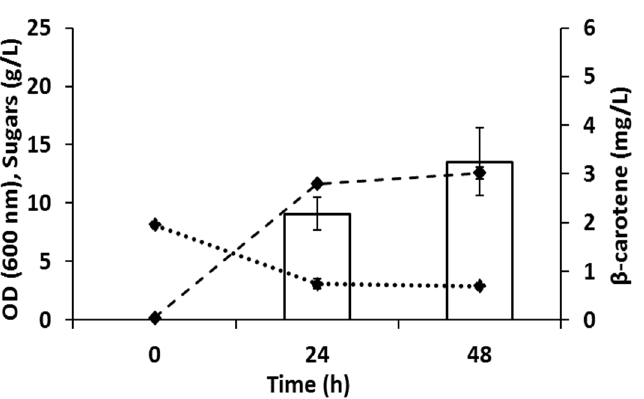
Figure 3. R. toruloides in SHF process with 9% ( w / v ) Camelina meal hydrolysed with 0.56% w / w Camelina R. toruloides in SHF process with 9% ( w / v ) Camelina meal hydrolysed with meal of NS22119 as growth medium. OD (dashed line), sugar consumption (dotted line), carotenoids 0.56% w / w Camelina meal of NS22119 as growth medium. OD (dashed line), sugar consumption (dotted production (white bars). Values are the means of three independent experiments. line), carotenoids production (white bars). Values are the means of three independent